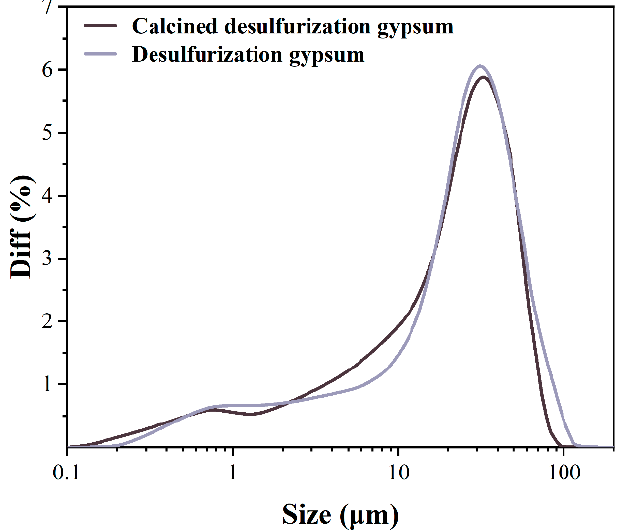
Figure 1. Particle size distribution of FGD gypsum.